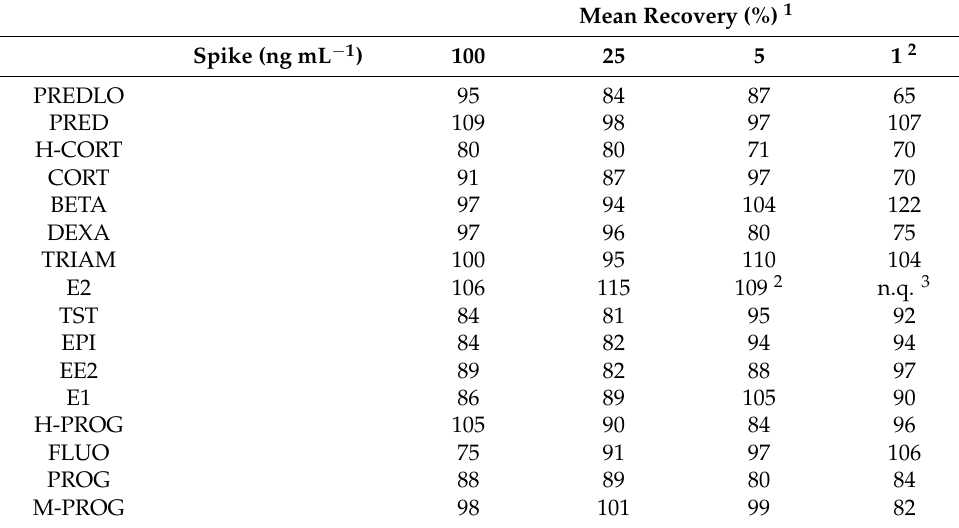
Table 4. Recoveries obtained in FBS by the optimized MSPE procedure followed by high-performance liquid chromatography coupled with mass spectrometry (HPLC–MS/MS) ( n =